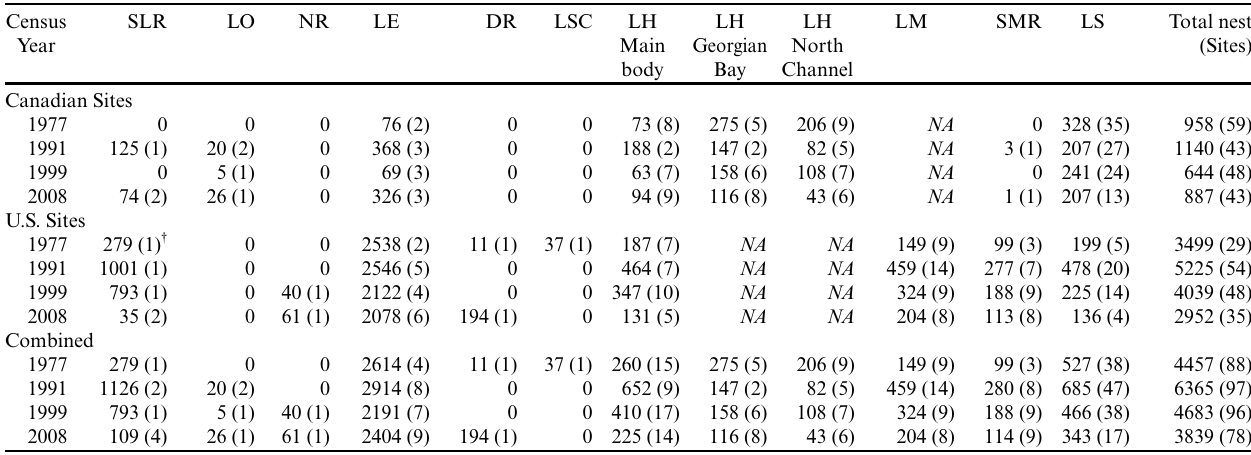
Table 3 . Location, size, and number of active Great Blue Heron ( Ardea herodias ) colonies by country and water body during the four decadal census periods. Values reflect total nest count per water body with number of active colony sites shown in parentheses. Values of zero indicate no nesting activity reported in water body during the indicated census period. NA denotes “not applicable” because the water body does not occur in both jurisdictions. DR indicates Detroit River; LE, Lake Erie; LH, Lake Huron; LM, Lake Michigan; LO, Lake Ontario; LSC, Lake St. Clair; LS, Lake Superior; NR, Niagara River; SLR, St. Lawrence River; SMR, St. Marys